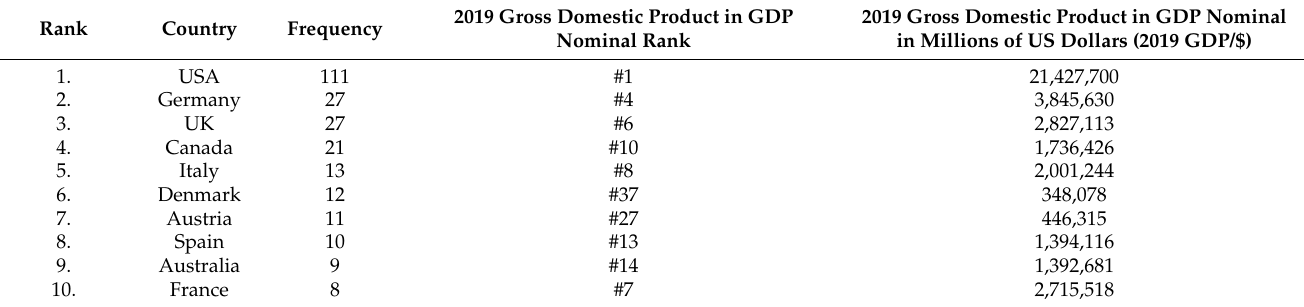
Table 13. Top 10 Country Scientific Production Data Visualization.